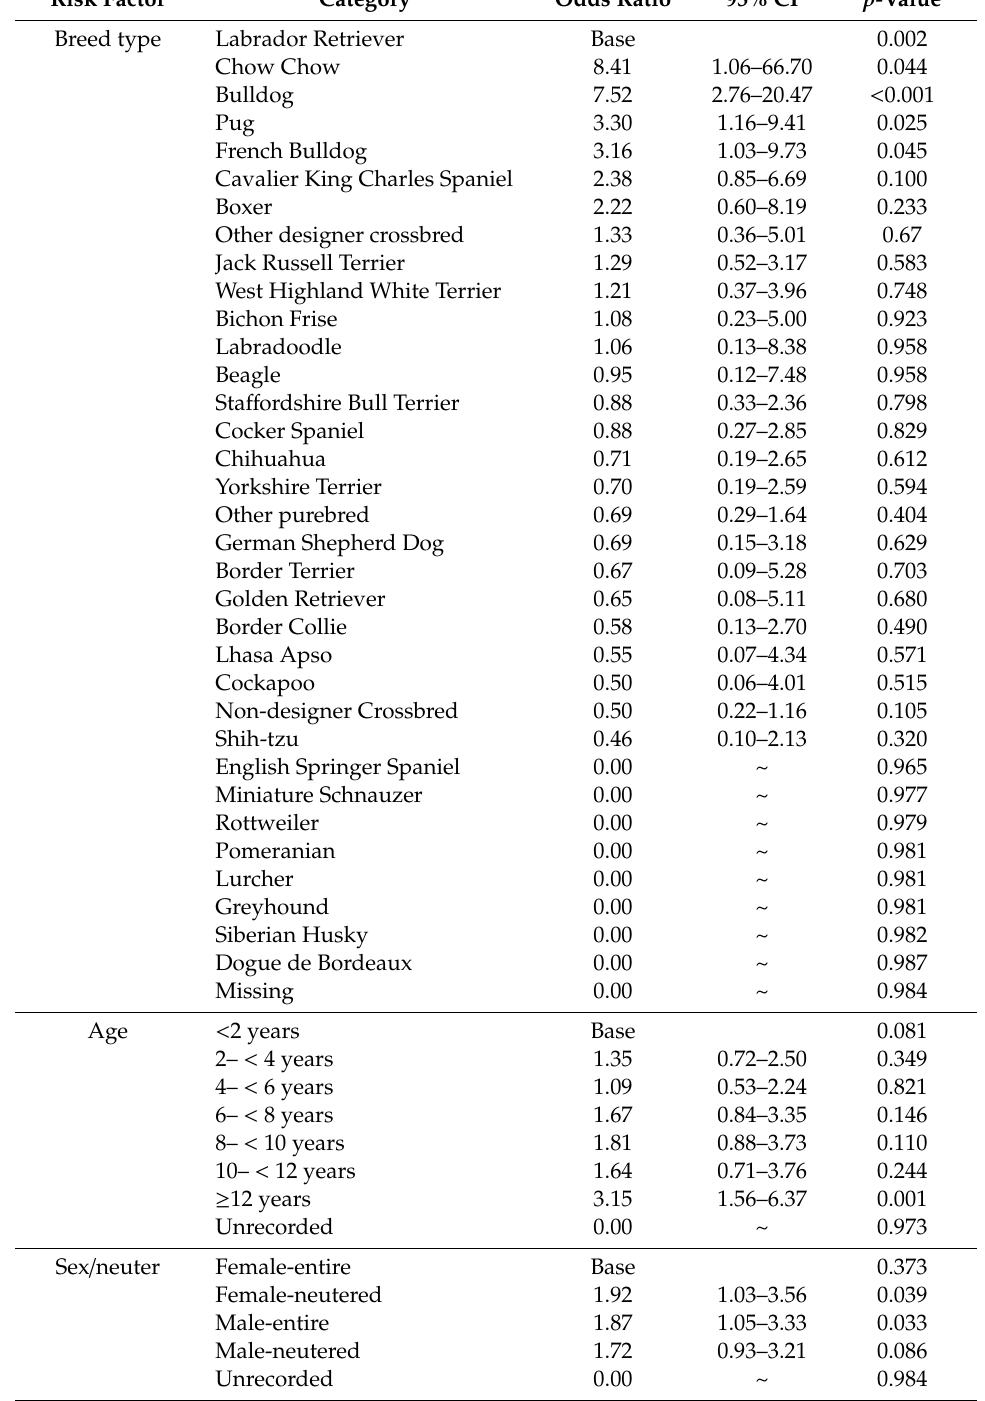
Table 4. Multivariable binary logistic regression results for risk factors associated with environmental heat-related illness in dogs under primary veterinary care in the VetCompass